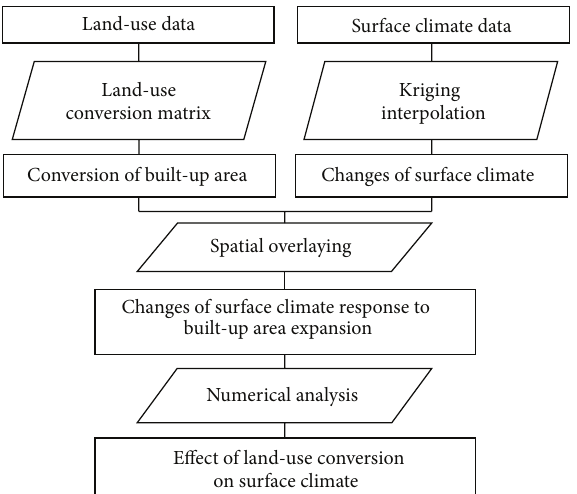
Figure 5: Distribution of built-up area, 1988–2008.